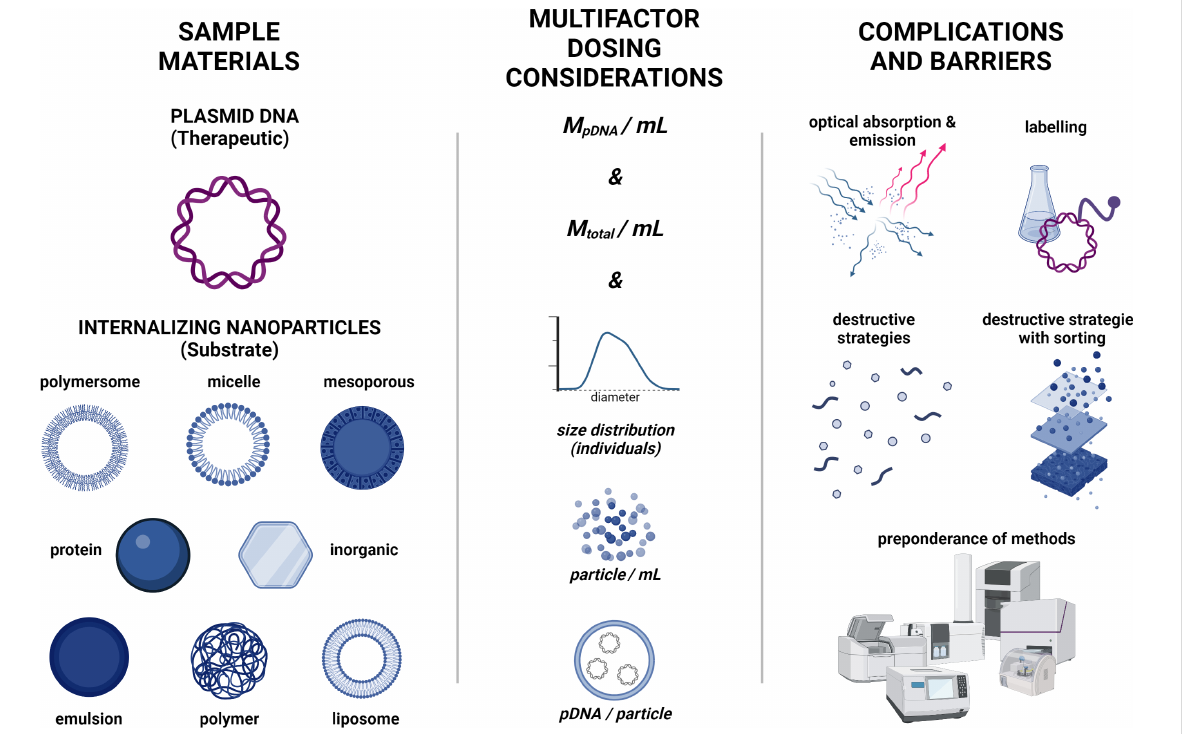
Figure 2: Practical concerns regarding dose determination in nucleic acid–NP systems. Left: Examples of possible pDNA internalization regimes. Center: Recommended dosing metrics that would be helpful for comparison between systems. Right: Barriers to acquisition of all key dosing metrics. Created with BioRender.com (https://biorender.com/). This content is not subject to CC BY